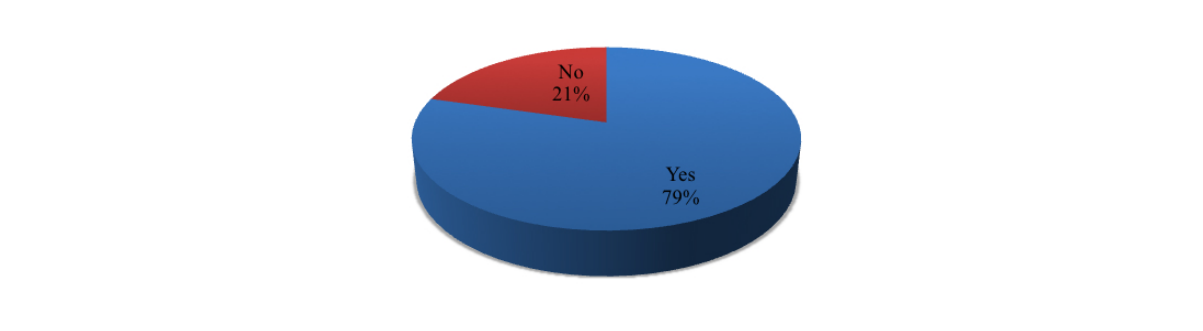
Figure 5. mHealth performance in cancer and cancer supportive care: empirical